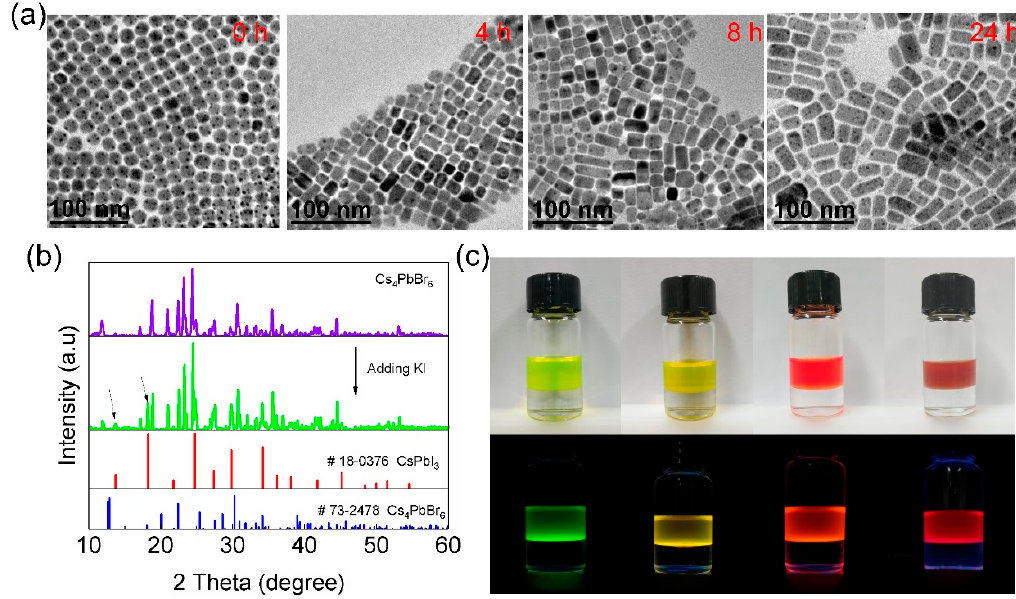
Figure 5. ( a ) Time-dependent TEM image of the product obtained by Cs 4 PbBr 6 NCs reacting with KI aqueous solution. ( b ) XRD pattern of the final product of KI aqueous solution reaction. ( c ) Digital photos of the system under sunlight and UV light.